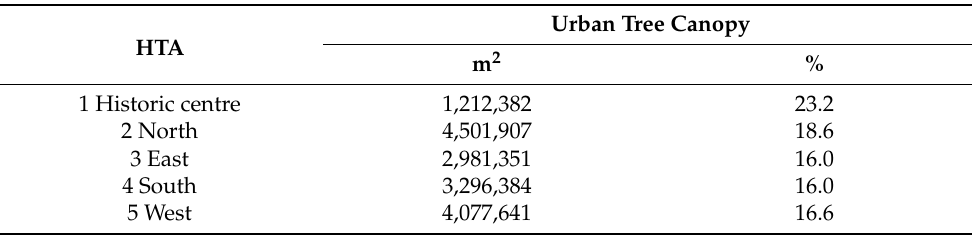
Table 1. Urban tree canopy expressed in m 2 and percentage of each total area in the five homogeneous territorial areas (HTAs) derived from NDVI maps and nDSM.